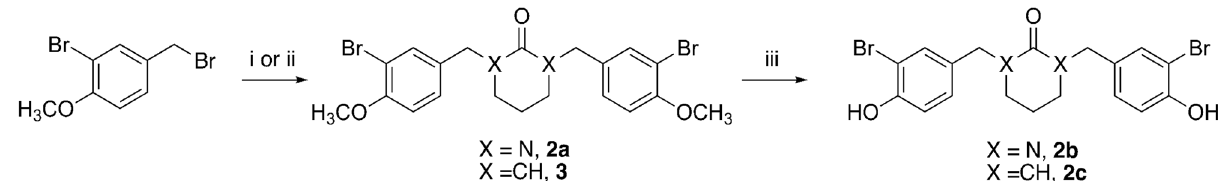
Figure 2. Synthetic route to 2a – c derivatives. i: NaH 60% dispersion in mineral oil, N , N ′ - trimethyleneurea, dioxane dry , reflux, 24 h, 50% yield; ii: 1. 1-(1-cyclohexen-1-yl)pyrrolidine, DIPEA, CHCl 3 , reflux, 12 h, 2. HCl 1 N, reflux, 4 h, 16% yield; iii: BBr 3 1 M in CH 2 Cl 2 , CH 2 Cl 2 dry , − 45 °C to rt, 2 h, 35–50% yield (see Section 4).